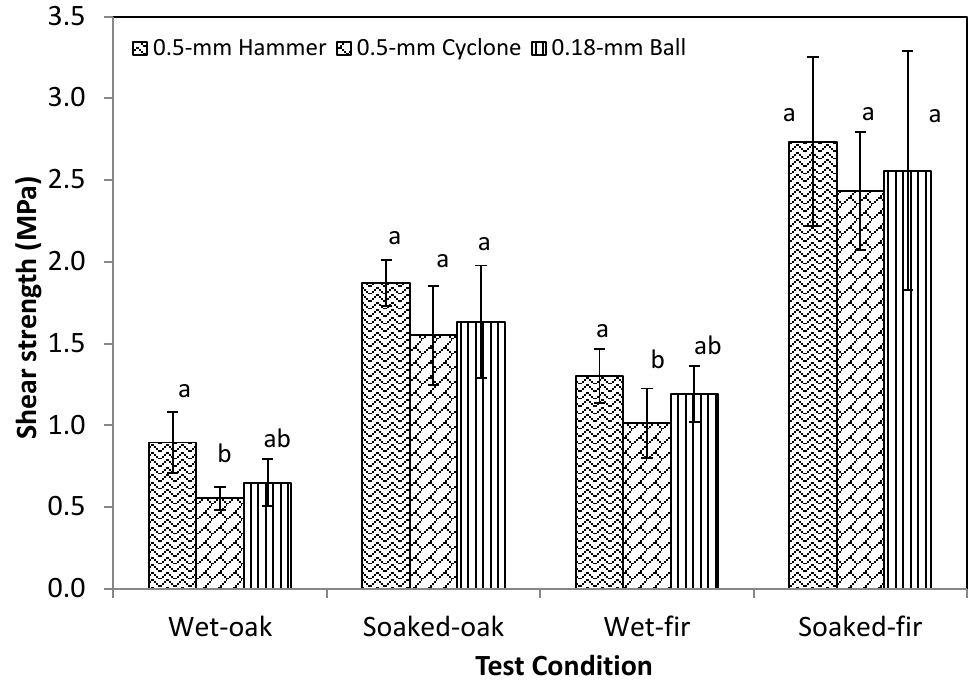
Figure 5. The shear strength of wet and soaked white oak and Douglas fir veneer pairs bonded by three WCSM products. Data are presented as average ± SD ( n = 10 for oak samples and 5 for fir samples). Different letters in the same type of strength indicate the statistically significant difference between the values at p ≤ 0.05.